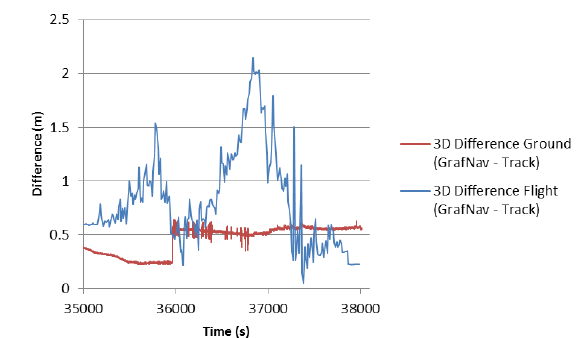
Figure 9. 3D differences between the GPS ground data and the reference position (tracking via SmartStation) compared to the 3D differences between the GPS airborne data and the corresponding reference data (Figure 7). The time scale of the second mentioned data set was adjusted in order to enable a direct comparison of these two approaches. In addition, a blunder in the GPS data acquired from the ground was eliminated, which corresponds possibly to a loss of signal lock in the GPS phase